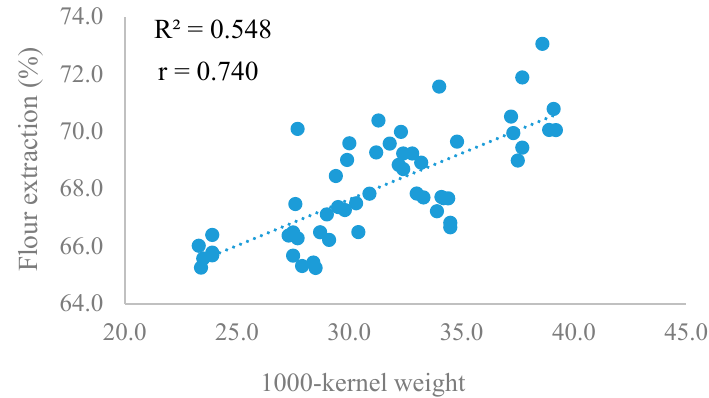
Figure 1. Correlation between 1000 kernel weight and flour milling extraction.